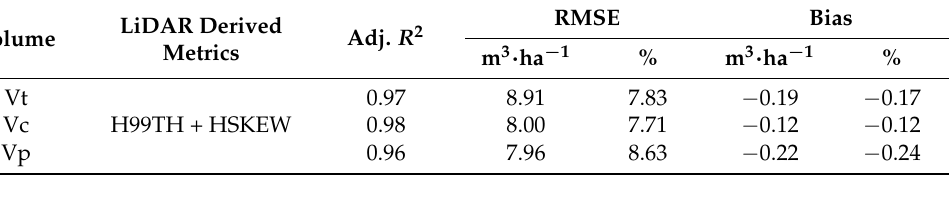
Table 6. Mean of the model improvement ratio (MIR) among the remained lidar-derived metrics not highly correlated. The bold represents the highest MIR values.